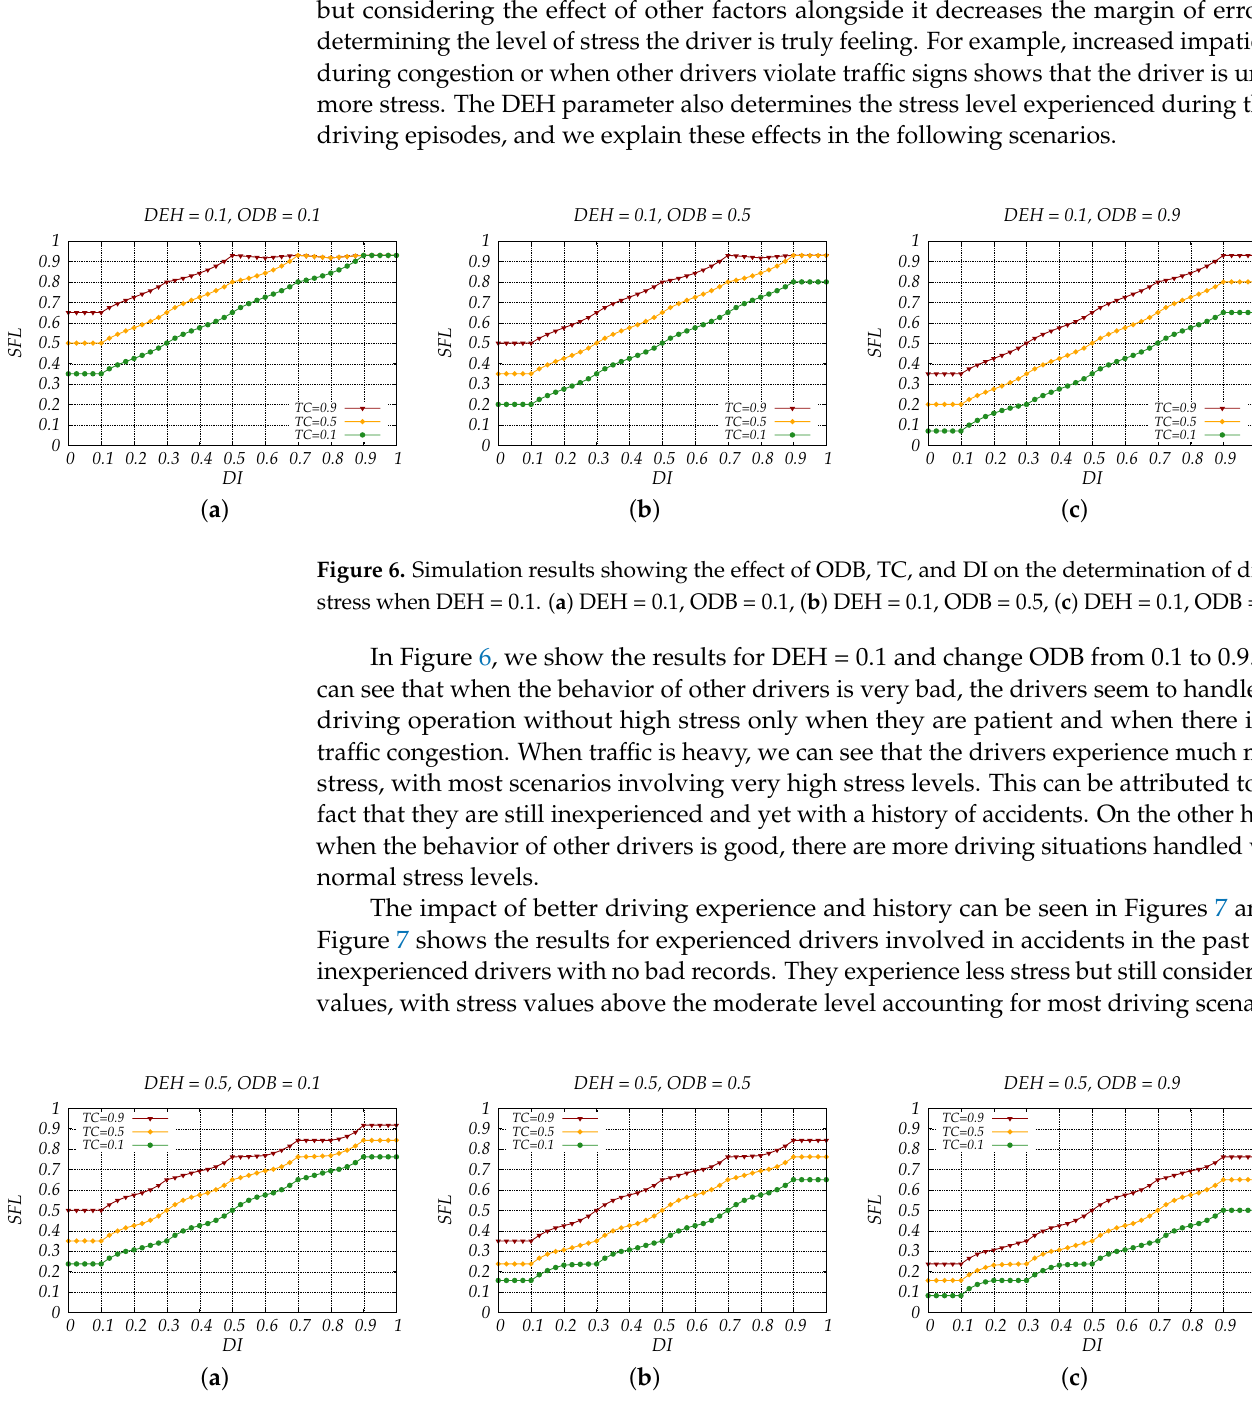
Figure 7. Simulation results showing the effect of ODB, TC, and DI on the determination of driver stress when DEH = 0.5. ( a ) DEH = 0.5, ODB = 0.1, ( b ) DEH = 0.5, ODB = 0.5, ( c ) DEH = 0.5, ODB =